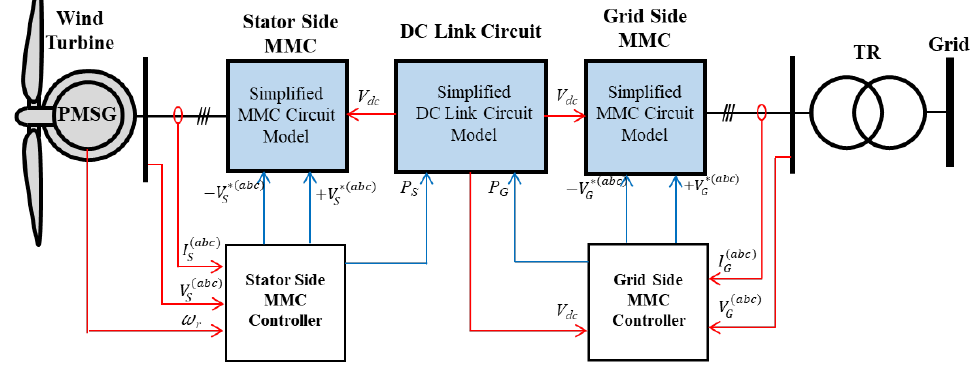
Figure 13. Average model configuration of a wind turbine generator.